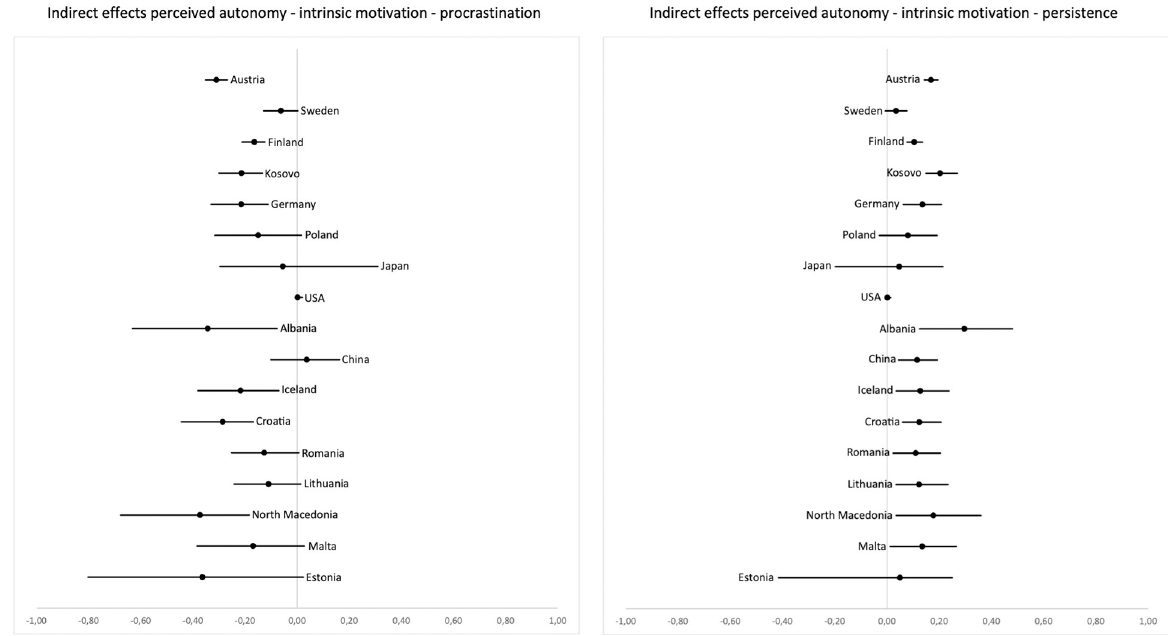
Fig 2. Unstandardized coefficients and two-sided 5% confidence intervals for the indirect effects of perceived autonomy on procrastination (left) and persistence (right), mediated by intrinsic motivation. Countries are ordered by sample size from top (highest) to bottom (lowest).